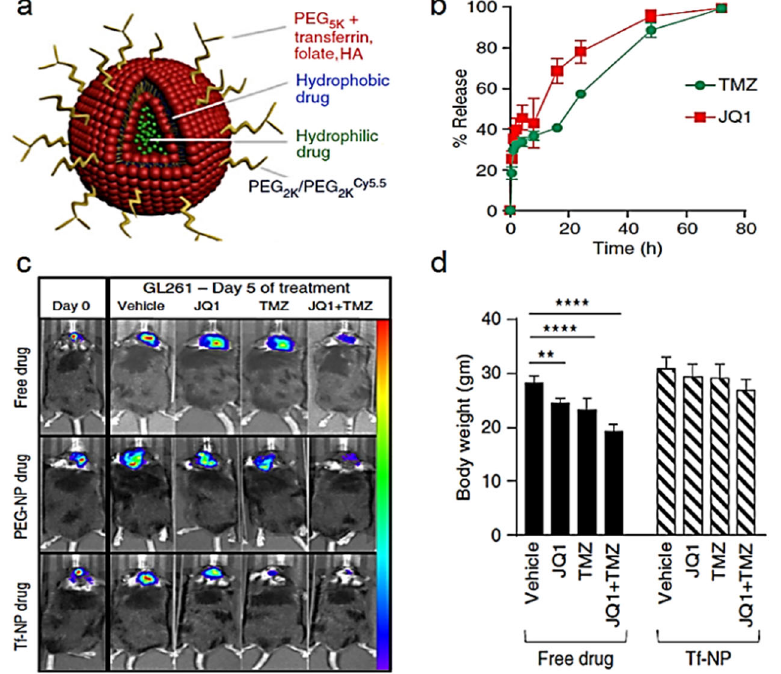
Figure 5. ( a ) Schematic of a PEGylated dual drug (TMZ + JQ1)-loaded liposome that can be func- tionalized (i.e., transferrin, folate, and hyaluronic acid (HA)) to enhance transport across the BBB and targeting to glioma cells; ( b ) Kinetics of drug release from liposomes loaded with both JQ1 and TMZ; ( c ) Bioluminescent images of GL261 mice taken on day 0 and day 5 following initiation of treatment with free drug formulations (free drug), drugs loaded in PEG-Cy5.5 liposomes (PEG-NP drug), or transferrin-PEG-Cy5.5 liposomes (Tf-NP drug); ( d ) quantification of average daily body weights of mice after 96 h of free drug and Tf-NP treatment course (Student t -test for n = 5; ** p ≤ 0.01; **** p ≤ 0.0001). Reproduced from Ref. [111] with permission of the copyright holder.